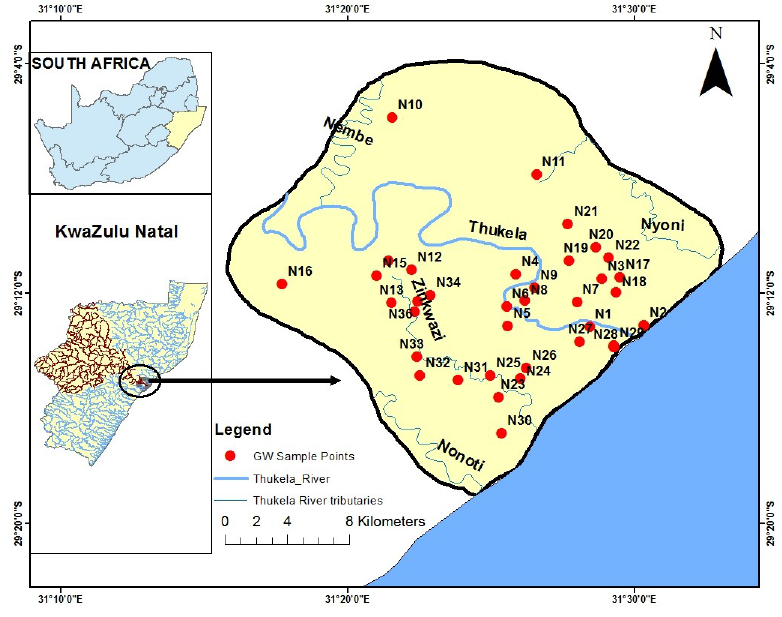
Figure 1. Location of study with monitoring wells.